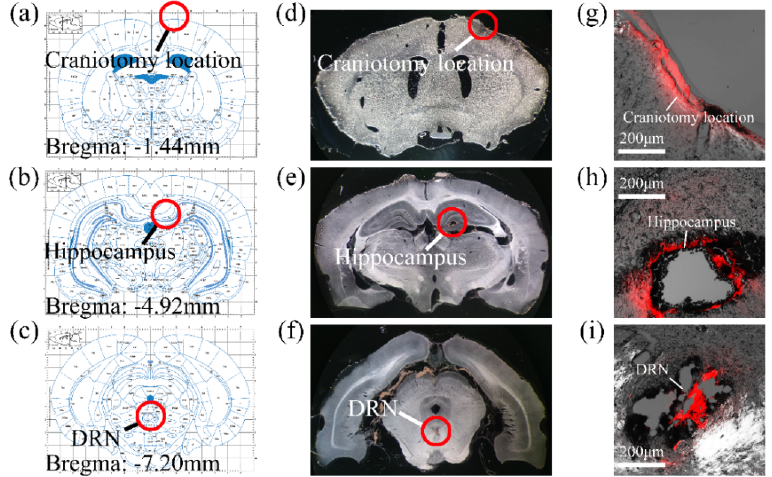
Figure 5. MEA implantation path verification. ( a ) Craniotomy location in the brain atlas; ( b ) Hippocampus in the brain atlas; ( c ) DRN in the brain atlas; ( d ) Craniotomy location in the brain slices; ( e ) Hippocampus in the brain slices; ( f ) DRN in the brain slices; ( g ) DiI traces at the craniotomy location by fluorescence microscopy; ( h ) DiI traces at the hippocampus by fluorescence microscopy; and ( i ) DiI traces in the DRN by fluorescence microscopy. ( a – i ) correspond with the coronal